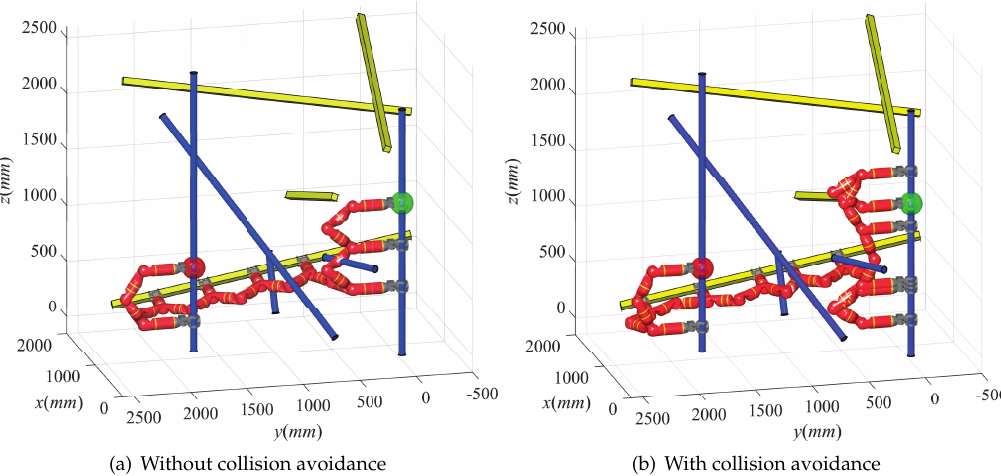
Figure 13. Comparison of results of grip planning with and without consideration of collision avoidance in a scene of 9